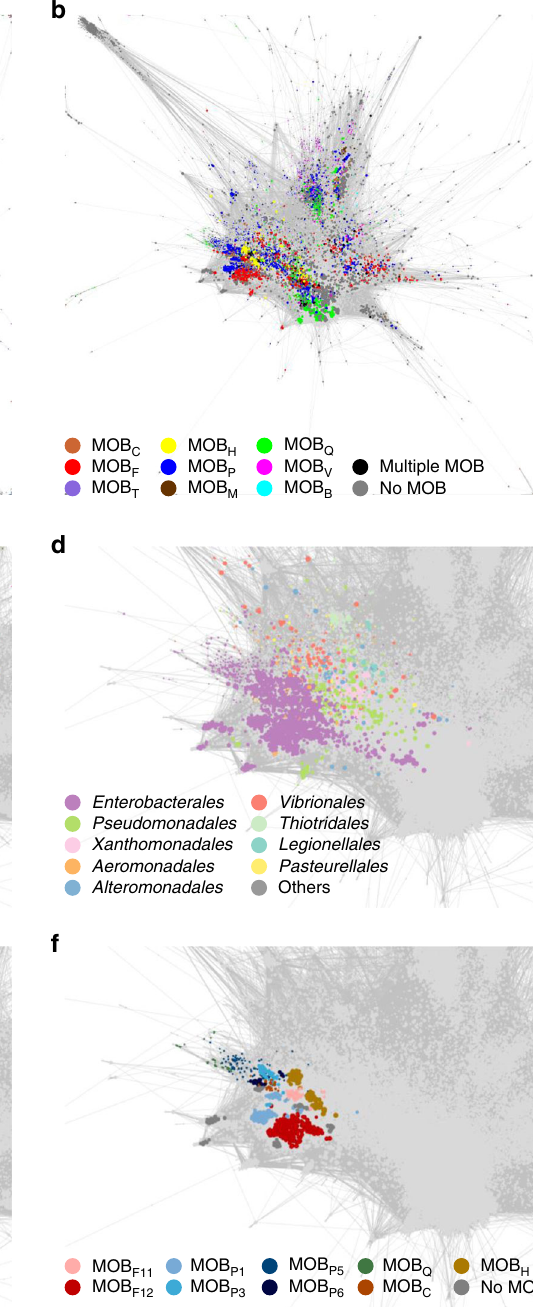
Fig. 1 Clustering of plasmid genomes along taxonomic boundaries. All graphs represent AcCNET bipartite networks, with nodes representing plasmid genomes (P) or homologous protein clusters (HPC), extracted from (P) as indicated in Methods. Whenever a P node encodes a member of a given HPC, an edge between both nodes is drawn. Edge lengths depend on the similarity to the most representative member of the cluster, as de fi ned by kClust. a , c – e panels show clustering by the host. Plasmid nodes were colored, as indicated in the respective color codes, by host phylum ( a ), host class within the Proteobacteria phylum ( c ), order-level within γ - proteobacteria ( d ), or genus-level, for the E. coli – Salmonella – Klebsiella group ( e ). b , f panels show clustering by MOB types in the overall plasmidome network ( b ) or in the family Enterobacteriaceae ( f ). Source data are provided as a Source Data fi